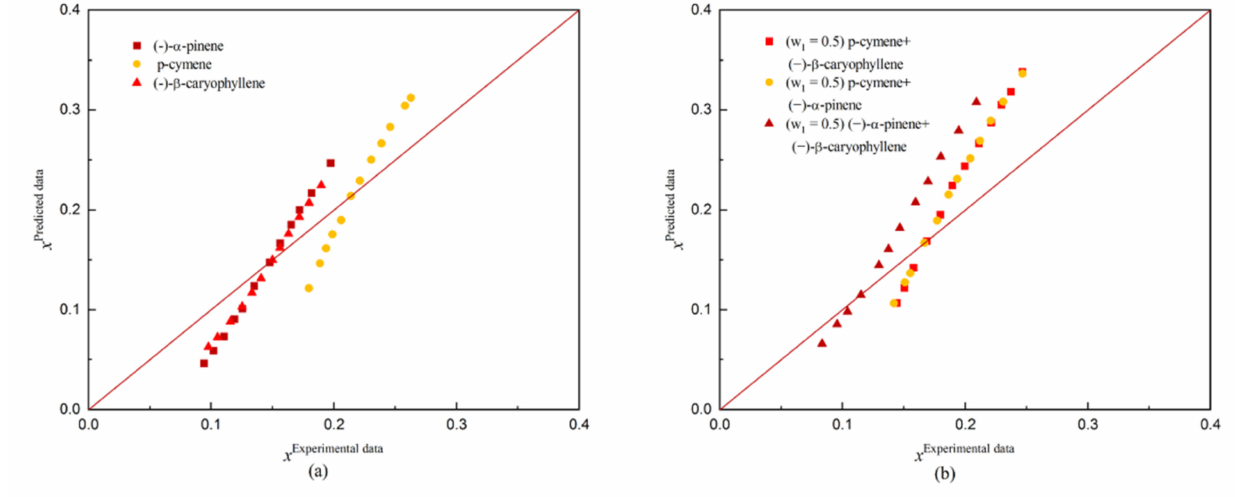
Figure 8. Comparison of COSMO-RS predicted and experimental solubility of dehydroabietic acid: ( a ) indicates the comparison in monosolvents; and ( b ) indicates the comparison in binary